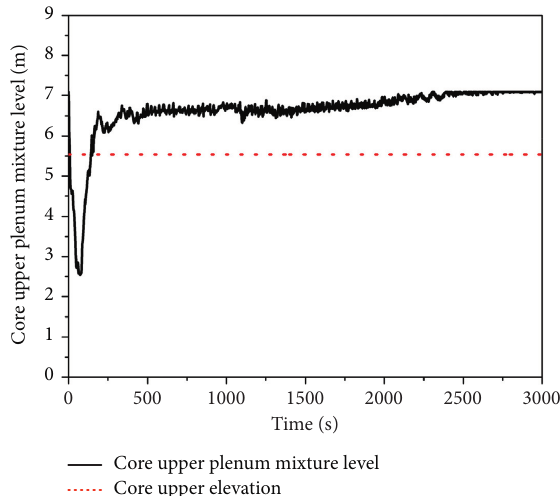
Figure 12: 10-inch CL break maximum cladding temperature.